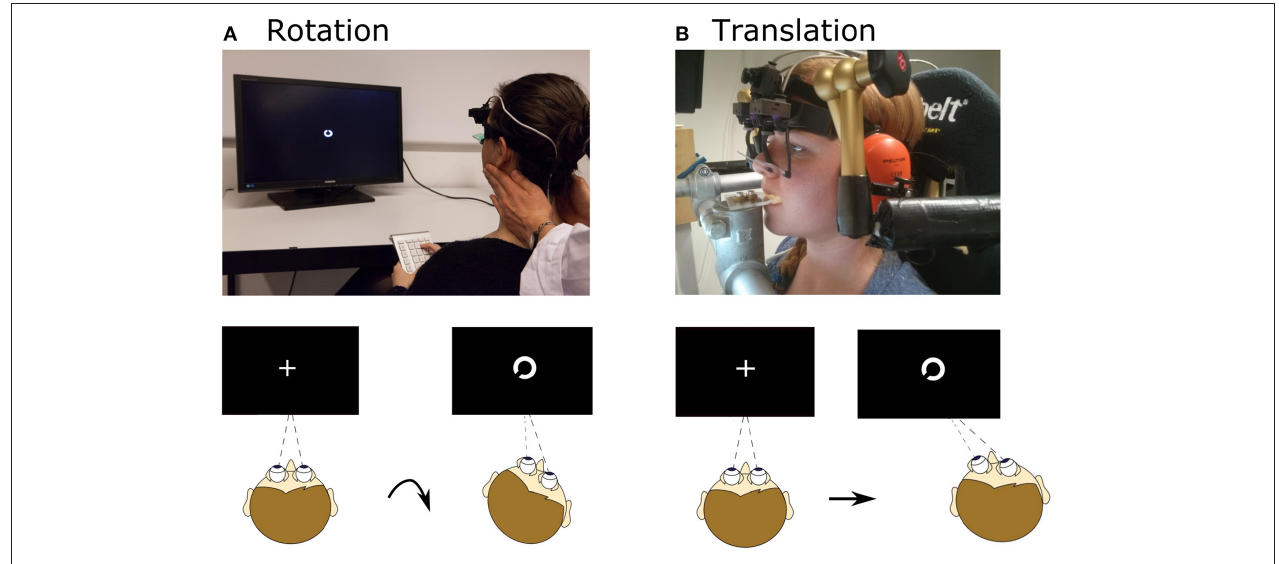
FIGURE 1 | Setup for rotational and translational VOR and DVA assessment. (A) Head rotation was induced by a trained experimenter manually rotating the head, as during a clinical head-impulse test. Subjects fixated a fixation point, which changed to a Landolt ring ∼ 72ms after movement onset and displayed for ∼ 68ms. After the movement subjects judged the orientation of the ring. (B) Translational movements were applied using a six-degree-of-freedom motion platform. The head was fixated with respect to the platform via bite bar and stabilizing braces over the ears. As for rotation, a Landolt ring appeared ∼ 75ms after movement onset and was displayed for ∼ 49ms; subjects judged its orientation. Written informed consent was obtained from the individual for the publication of the image represented in the